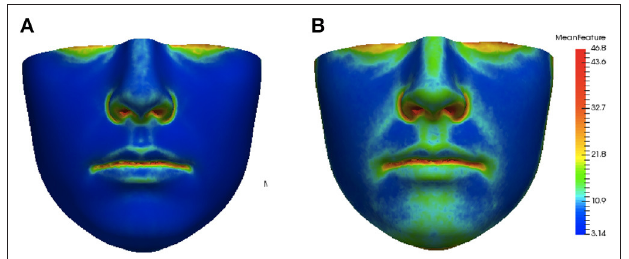
FIGURE 6 | Group average heat maps from subjects with low asymmetry (angle of surface orientation score in lower 10 percent of data set) (A) and subjects with high asymmetry (angle of surface orientation score in upper 10 percent of data set) (B) . Regions with low asymmetry are blue and regions with high asymmetry are